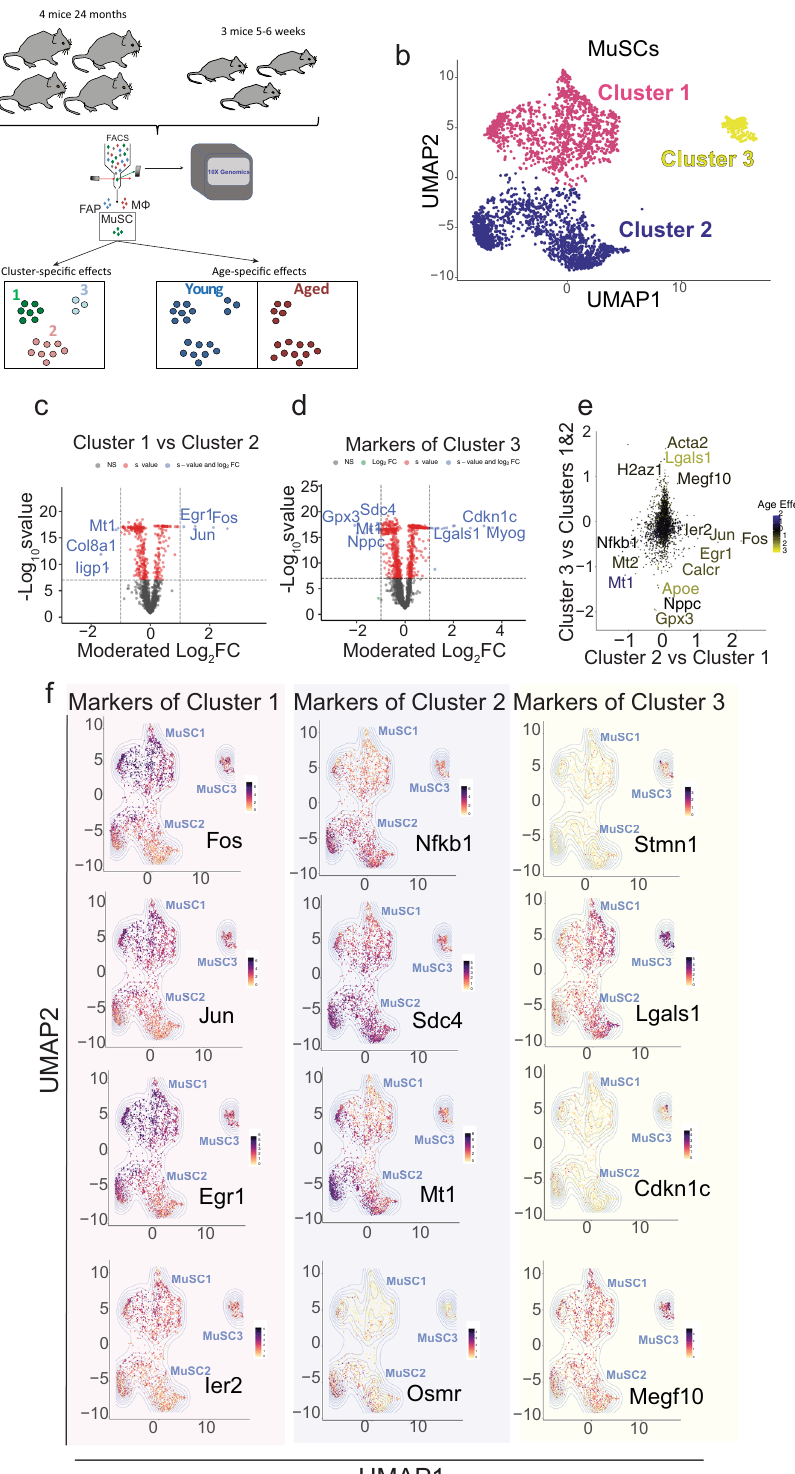
Fig.2|MuSCscanbeclassi fi edintothreemainclusters.a Schematicdiagramof the scRNA-seqanalysison young and agedMuSCs. b UMAPembedding of MuSCs, colored based on cluster. c Volcano plots showing genes that are up or down- regulatedinCluster1comparedtoCluster2ofMuSCs,atathresholdofmoderated LFC>1 and s -value < 10 − 8 . d Volcano plots showing genes that are up or down- regulated in Cluster 3 compared to Clusters 1 and 2, at a threshold of moderated